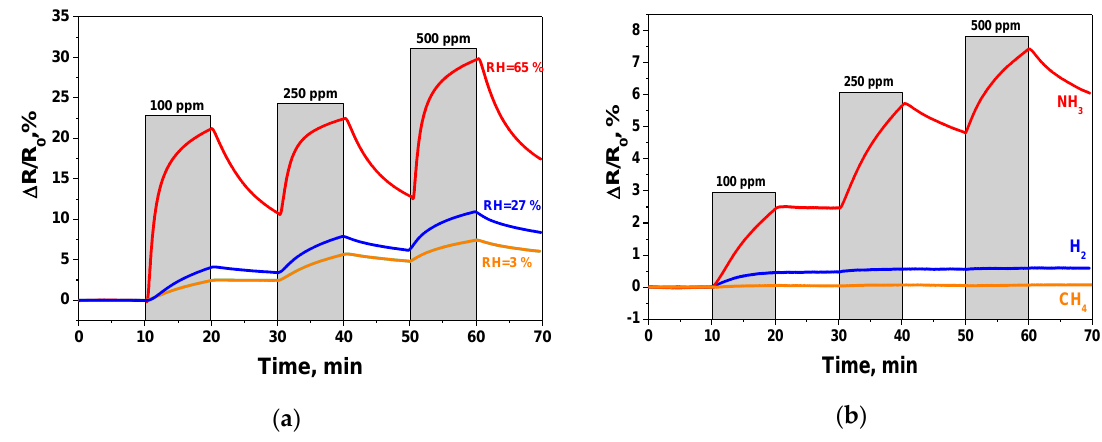
Figure 5. GO sensor response obtained at room temperature: ( a ) influence of increasing RH on response; ( b ) response towards different gases in dry air (RH = 3%).